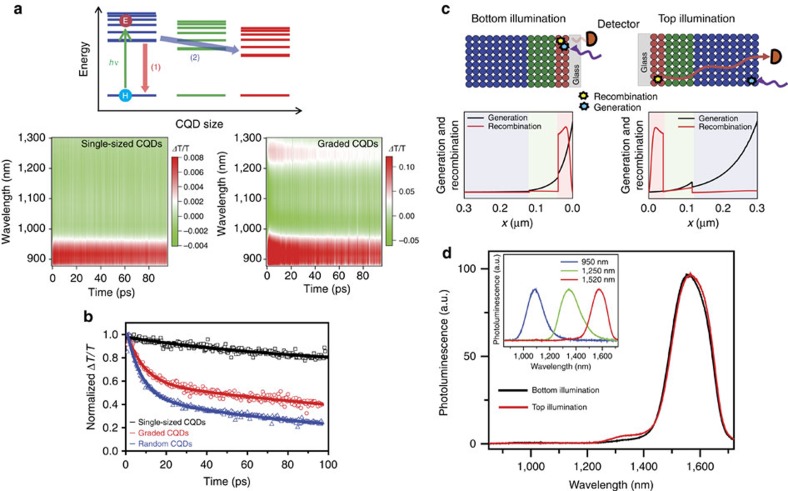
Funnel characteristics in graded CQD solids formed by C3.(a,b) Exciton recombination and charge transfer in graded CQD solids (a, top). In single-sized CQDs, photogenerated electrons undergo ultrafast intraband relaxation and subsequent exciton recombination. In contrast, both (1) exciton recombination and (2) charge transfer to a layer of larger CQDs can occur in graded CQDs. Time evolution of transient absorption (TA) spectra for single-sized CQDs (left) and graded CQDs (right) (a, bottom). The positive signal at wavelengths smaller than 950 nm is observed for both single-sized CQDs and graded CQDs and arises from the bleaching of the lowest exciton transition in the smallest CQDs. (b) Time profiles of transient absorption signals at 950 nm probe wavelength (points) and their exponential fits (lines) for single-sized (black), graded (red) and randomly mixed (blue) CQDs. (c,d) Photoluminescence studies of the graded CQD film formed on glass substrate under illumination from the small-bandgap side (bottom illumination) and the large-bandgap side (top illumination) of the graded film (c, top). For the measurements, films were illuminated with a laser beam at λ=440 nm, and the emission was collected from the same side where light is illuminated. The CQD layer was composed of ∼180-, ∼80- and ∼40-nm thick CQD films with corresponding excitonic peaks at 950 (blue), 1,250 (green) and 1,520 nm (red), respectively. (d) The photoluminescence spectra when illuminating from either side overlap closely. The inset shows the photoluminescence spectral profile emitted from each CQD materials. From this we conclude that photogenerated charge carriers are efficiently funnelled to the small-bandgap material in the graded film. This is consistent with generation and recombination plots of both structures predicted using the electronic materials parameters associated with the CQD films (c, bottom). Colour-shaded regions are representative of film thicknesses for each size of CQD.